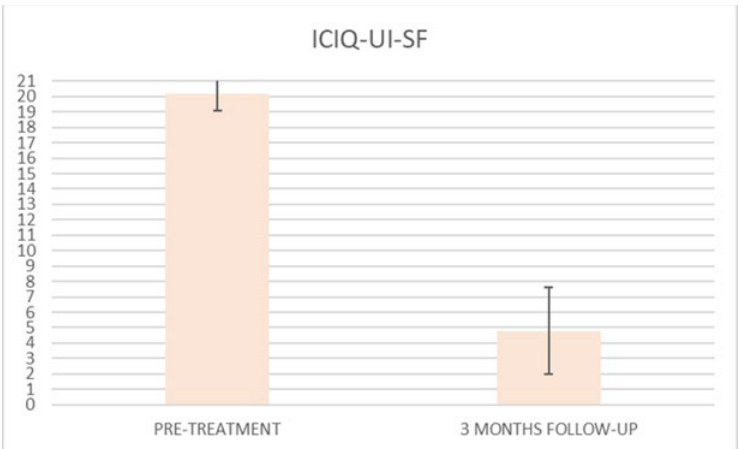
Figure 3. Histogram representation of the results from ICIQ-UI-SF at baseline and at 3 months follow-up.